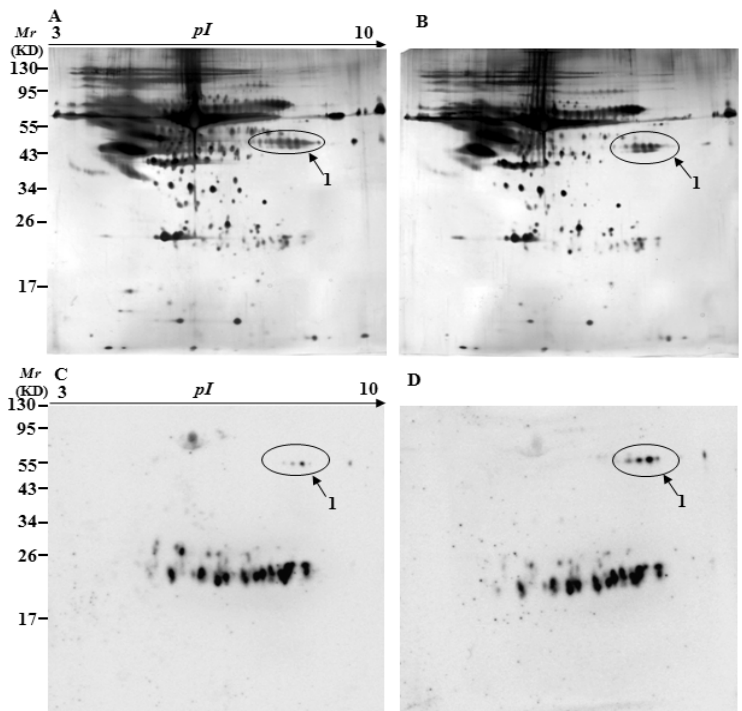
Figure 4. Silver-stained gels and 2D-oxyblots of the serum extracts from six-month-old controls to 3×Tg-AD mice. Representative 2D gel images of the serum proteomes of the control ( A ) and 3×Tg-AD mice ( B ); ( C , D ) are the oxyblots of serums from the control to 3×Tg-AD mice, respectively. Spots that showed a significant difference in specific carbonylation levels are marked with the corresponding protein identity.